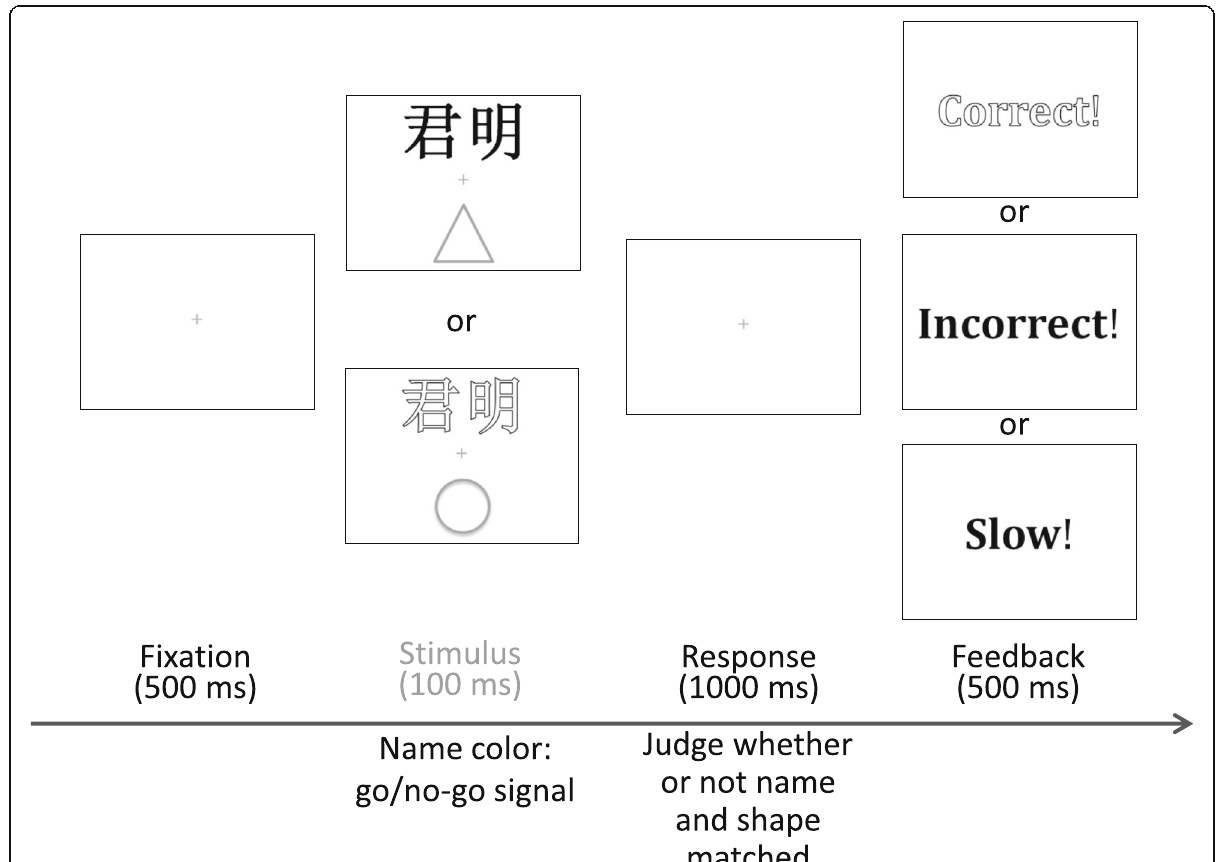
Fig. 1 Experimental procedure. The stimuli in the experiment were presented against a black background. Stimuli with an open font represent words colored in red; those with a solid font represent words colored in